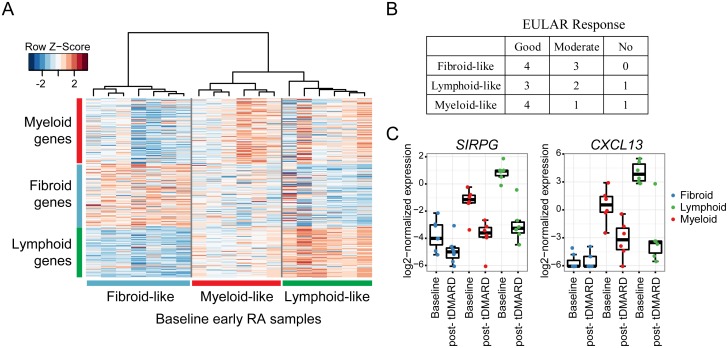
RA samples can be grouped into subtypes based on previously identified gene expression features.(A) Hierarchical clustering of baseline early RA samples using features previously published (Dennis et al., 2014 [13]). (B) Table of EULAR response after 6 months of tDMARD treatment based on inferred synovial subtypes at baseline. (C) Expression of example genes grouped by visit and synovial subtype.